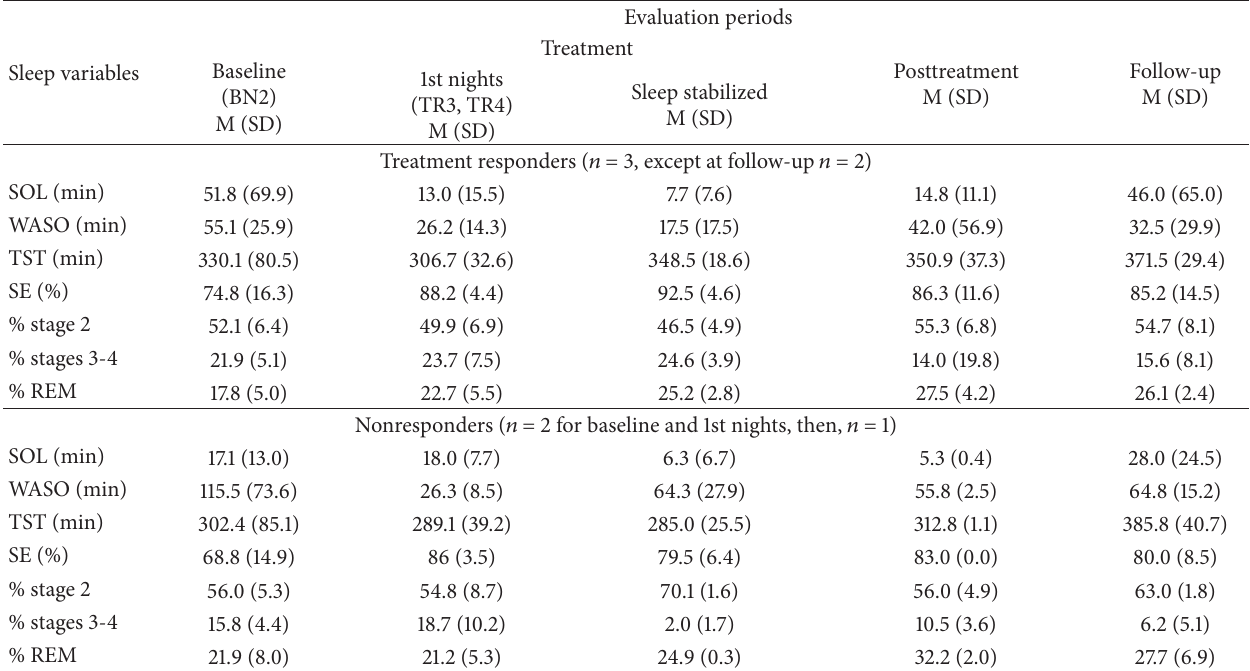
Table 4: Means (M) and standard deviations (SD) of polysomnographic data.